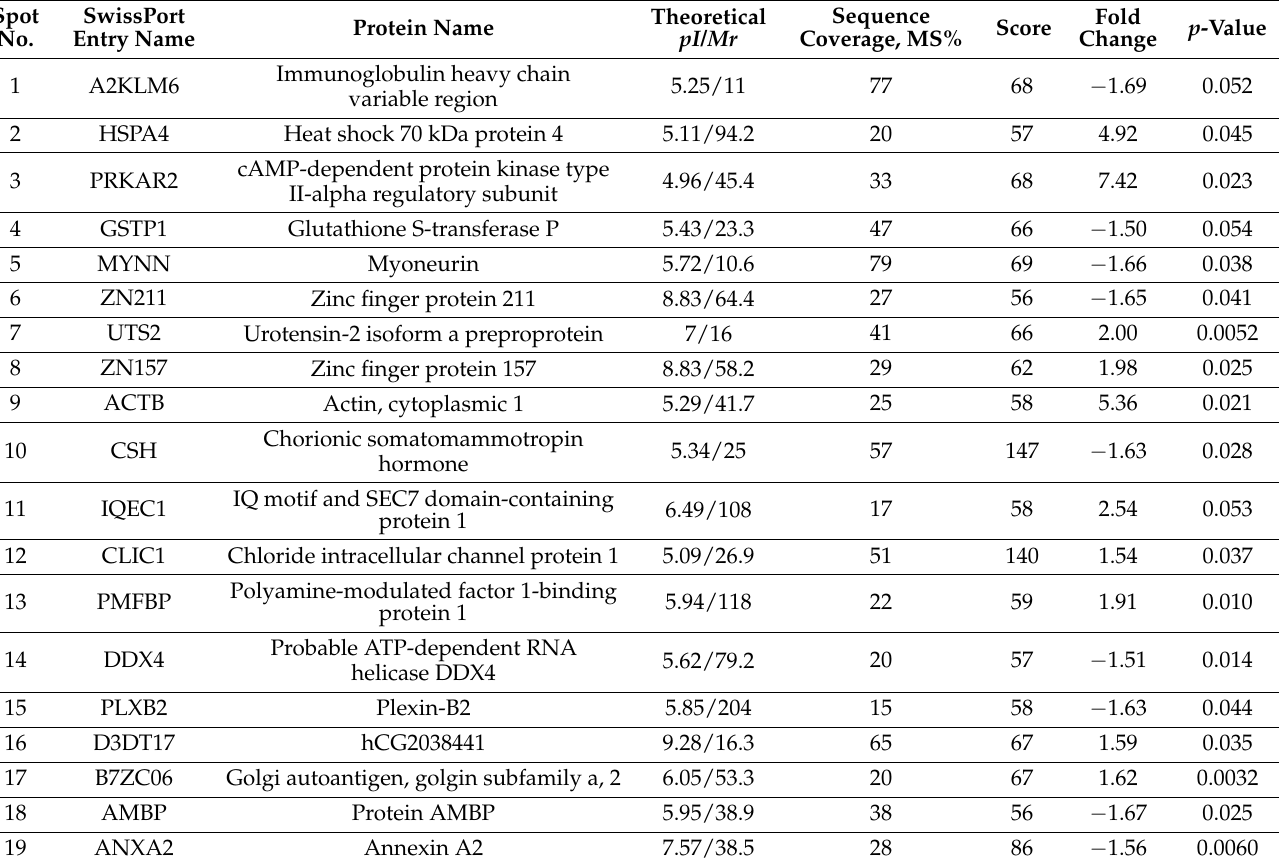
Table 3. Details of the differentially abundant proteins identified between five NP and five PAS pla- centa tissues. We used 2D-DIGE and MALDI TOF/TOF to quantify and identify proteins, respectively. The theoretical pI/Mr, sequence coverage and score were determined by the MALDI TOP/TOF assay. The fold change and p -value were calculate by the 2D-DIGE assay. Positive fold change denoted a higher abundance in PAS samples. p -value was calculated based on a t